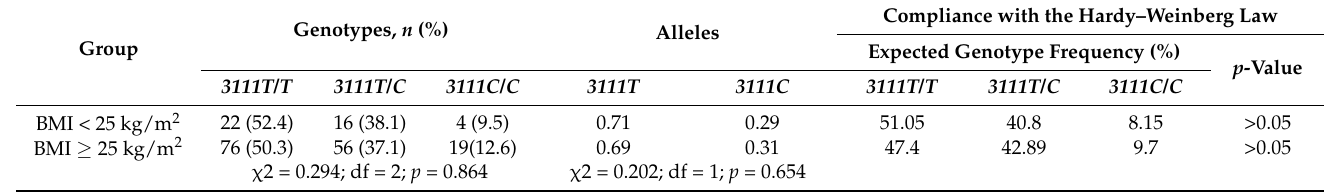
Table 2. The frequencies of the Circadian locomoter output cycles protein kaput (CLOCK) 3111T/C ( rs 1801260 ) gene polymor- phism genotypes and alleles in the groups.